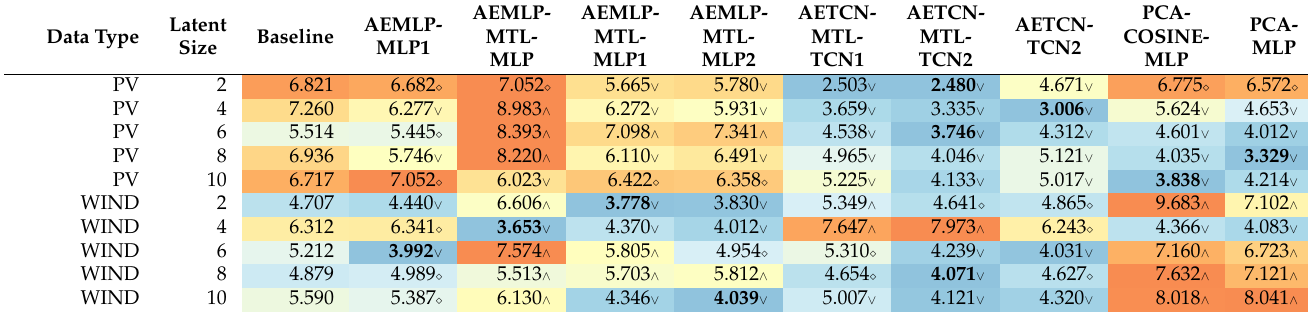
Table 7. Rank summary of the forecast error for best models and latent sizes for the autoencoder models (see Table 2), and the PCA-based models. AEMLP-MTL-MLP is the baseline and all models were tested to determine whether the mean performance rank was significantly better ( ∨ ), worse ( ∧ ), or not significantly different ( (cid:5) ) compared to the baseline. We tested for a significant difference with the Wilcoxon test ( α = 0.01). The colors denote the respective rank. Blue indicates a smaller (better) rank and red a higher (worse) rank. The best model for a latent size and data type is highlighted in bold.